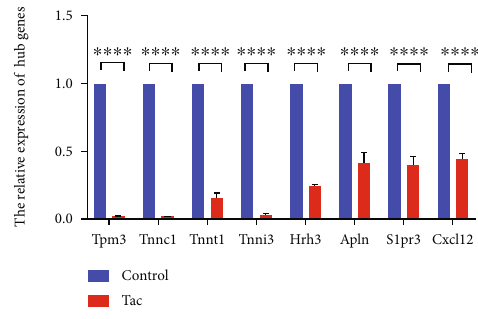
Figure 7: The relative expression of hub genes. Data are means ± SD . ∗∗∗∗ p < 0 : 0001